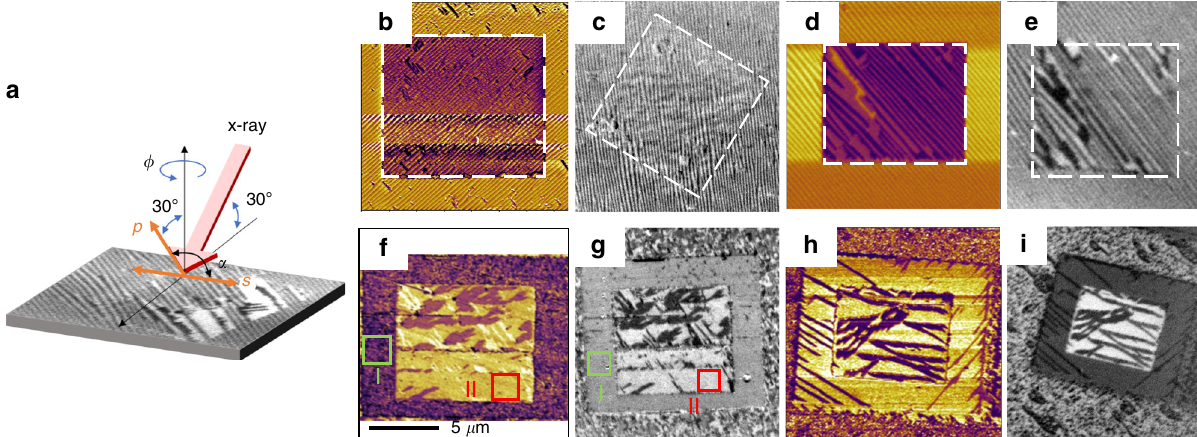
Fig. 4 PFM and XMLD-PEEM images of BiFeO 3 and Bi 0.85 La 0.15 FeO 3 thin fi lms. a Schematic of the XMLD-PEEM experimental geometries used to probe the angle dependence ( Φ ), linear dichroism. Linear polarizations: α = 0°; Linear polarization p: α = 90°. b , c In-plane-PFM and XMLD-PEEM images of 80-nm-thick BiFeO 3 . d , e In-plane-PFM and XMLD-PEEM images of 20-nm-thick BiFeO 3 . f , g In-plane-PFM and XMLD-PEEM images of 80-nm-thick Bi 0.85 La 0.15 FeO 3 . The green/red boxes represent the positive/negative polarized domain I/II. h , i In-plane-PFM and XMLD-PEEM images of 20-nm-thick Bi 0.85 La 0.15 FeO 3